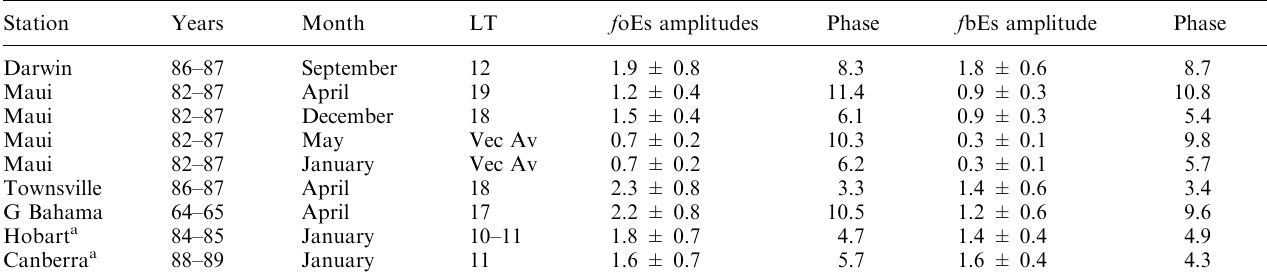
Table 2. f oEs and f bEs comparison Station